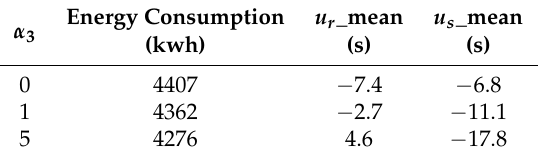
Table 4. The effects of α 3 on the energy consumption and control action.